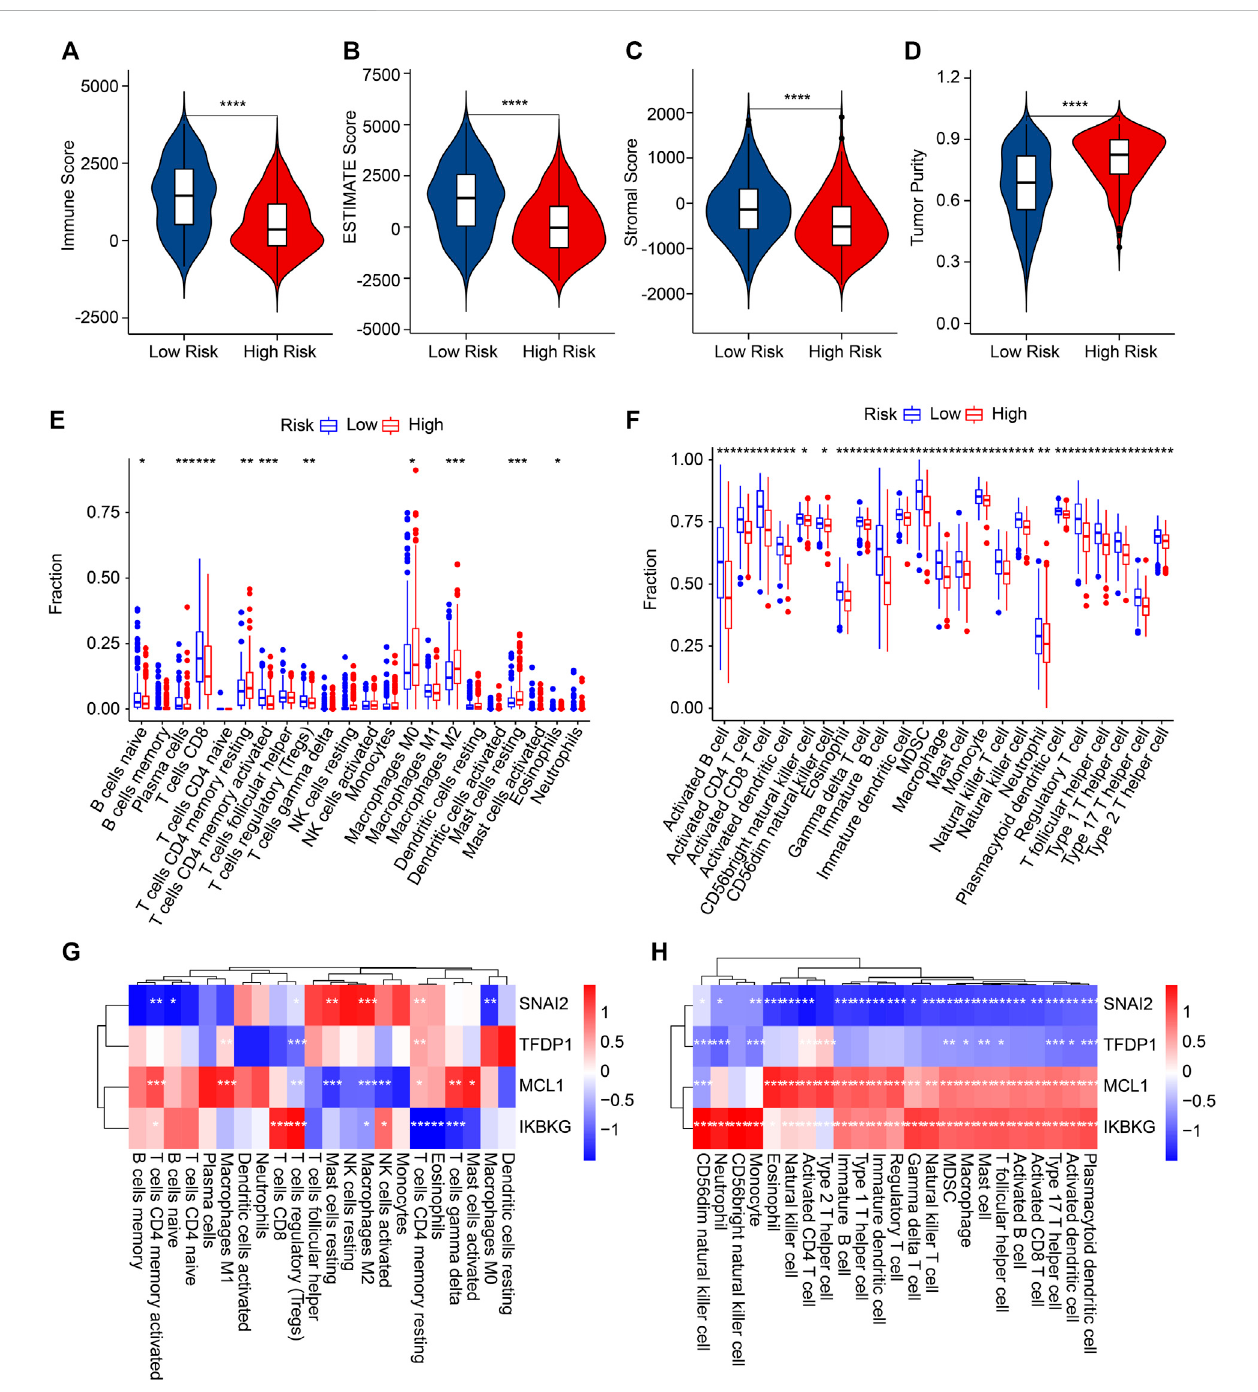
FIGURE 7 The results of immune in fi ltration landscape: (A) immune score, (B) ESTIMATE score, (C) stromal score, (D) tumor purity, (E) the proportion of 22-type cells of patients in the different risk groups, (F) the proportion of 23-type cells. (G,H) Correlation analysis of ARGs and immune cells. * p < 0.05, ** p < 0.01, *** p < 0.001, **** p <